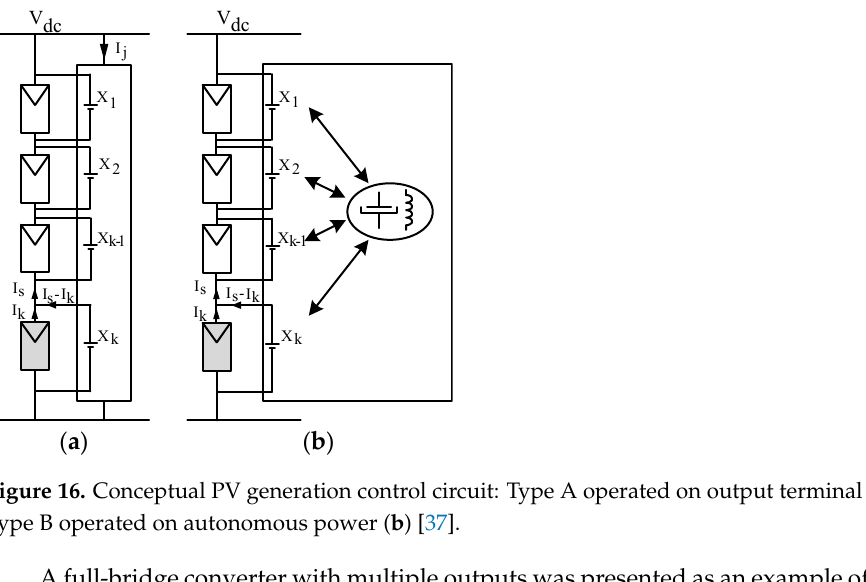
Figure 15. String series (voltage) compensation: converter per array ( a ); converter per string ( b ).